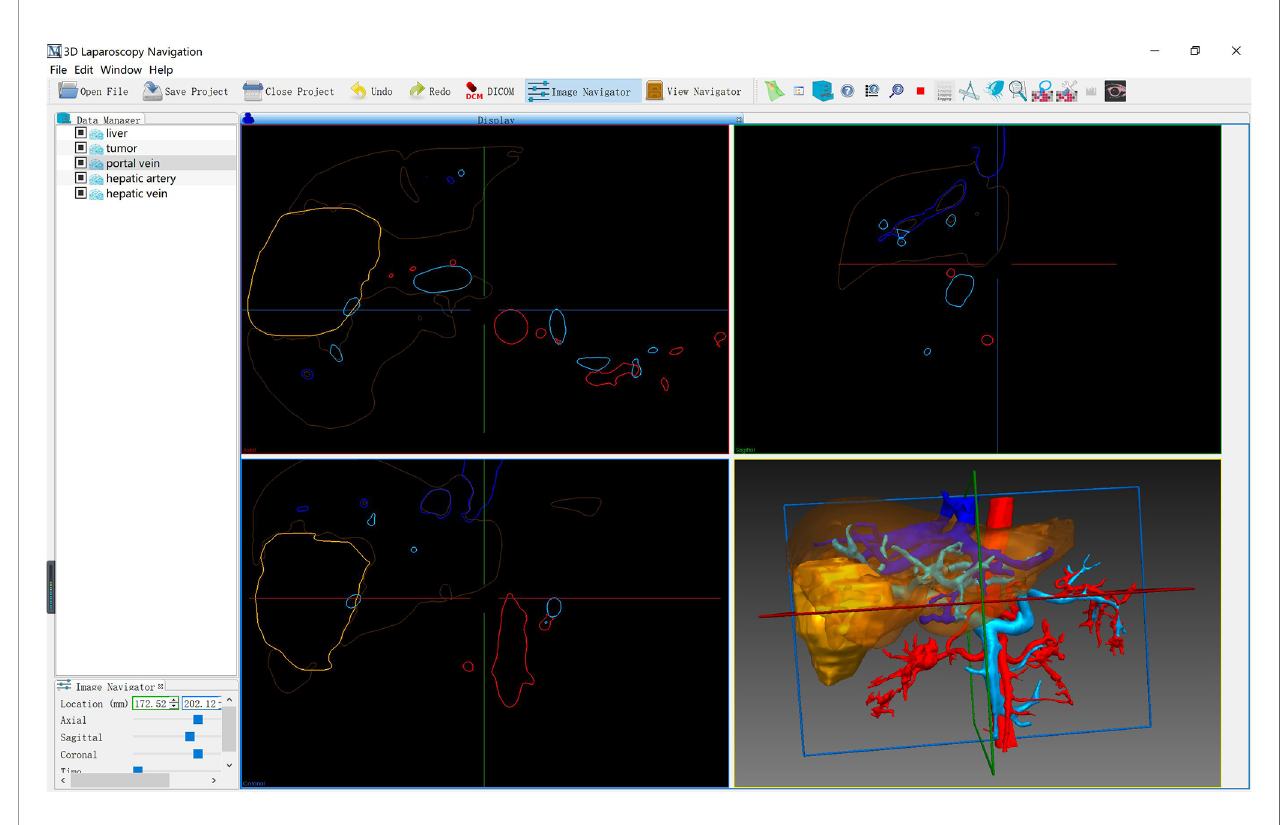
FIGURE 1 | 3D LARN software